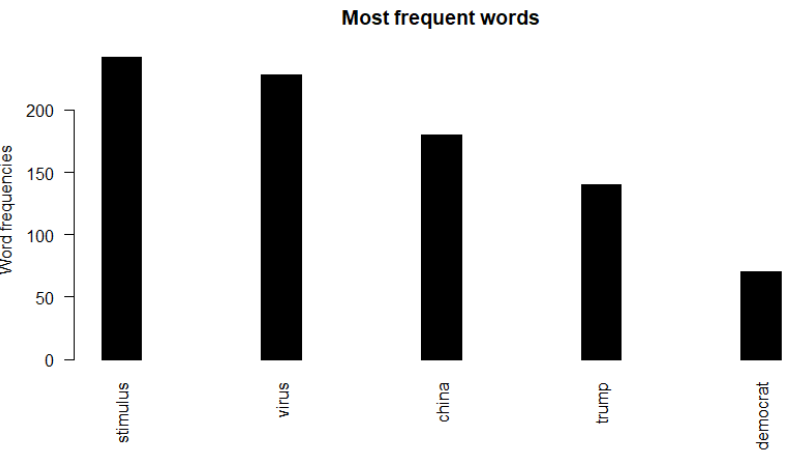
Figure 1. Histogram of absolute frequencies of KU terms in 2020. Notes: The figure graphs the frequency of KU event terms as reported in Bloomberg News stock market wrap reports for 2020.